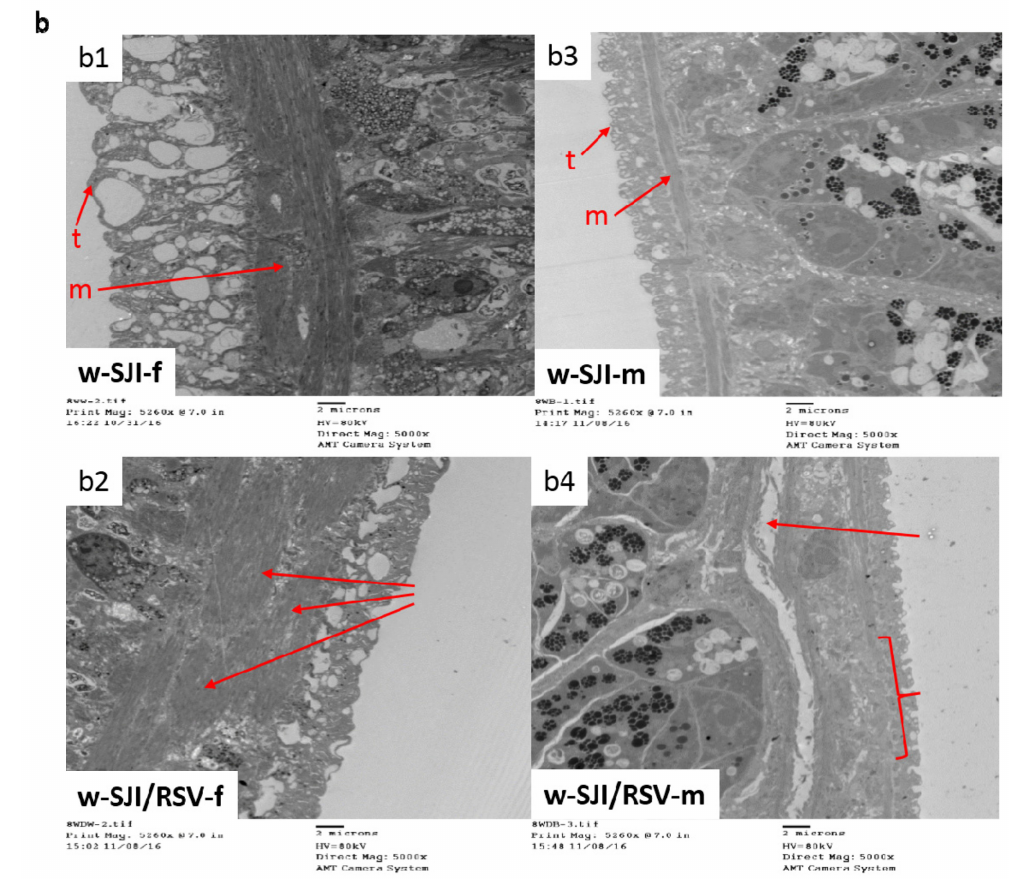
Figure 6. RSV damages the external epidermal tissue and internal cavity composition of adult S. japonicum worms obtained from infected mice at 8 and 10 weeks after infection. ( a ) Representative scanning electron microscopy images show the external epidermis of the adult worms at 8 and 10 weeks after infection. RSV not only induces swelling of the worms, but also induces loosening of the clefts and fusion of ridges. In addition, it results in the formation of holes and regions with extensive vesiculation, bursting of blebs, erosion of the tegument and sloughing (a4-6 and a10-12, red arrows). Non-treated mice were used as the control. ( b ) Representative transmission electron microscopy images showing that RSV not only damages the internal cavity of worms and results in thinning of the tegument, but also results in the swelling of muscle bundles (b2 and b4, red arrows). (n = 5 for each